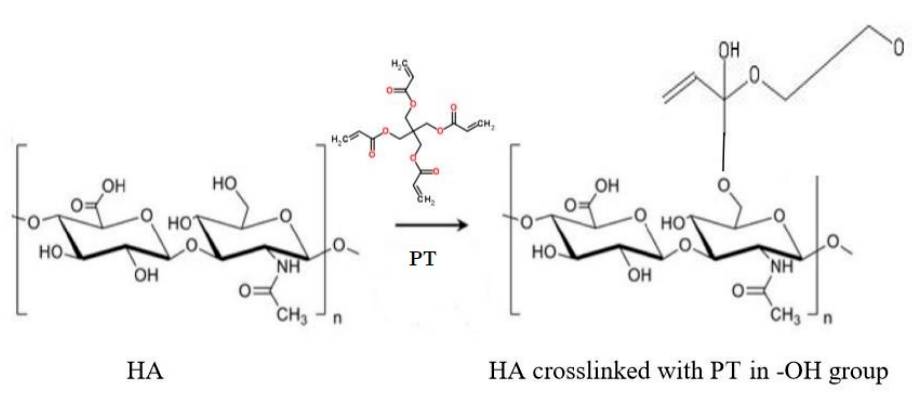
Figure 4. Crosslinking between HA and PT polymers via the -OH group of the HA and carbonyl carbon of the PT.